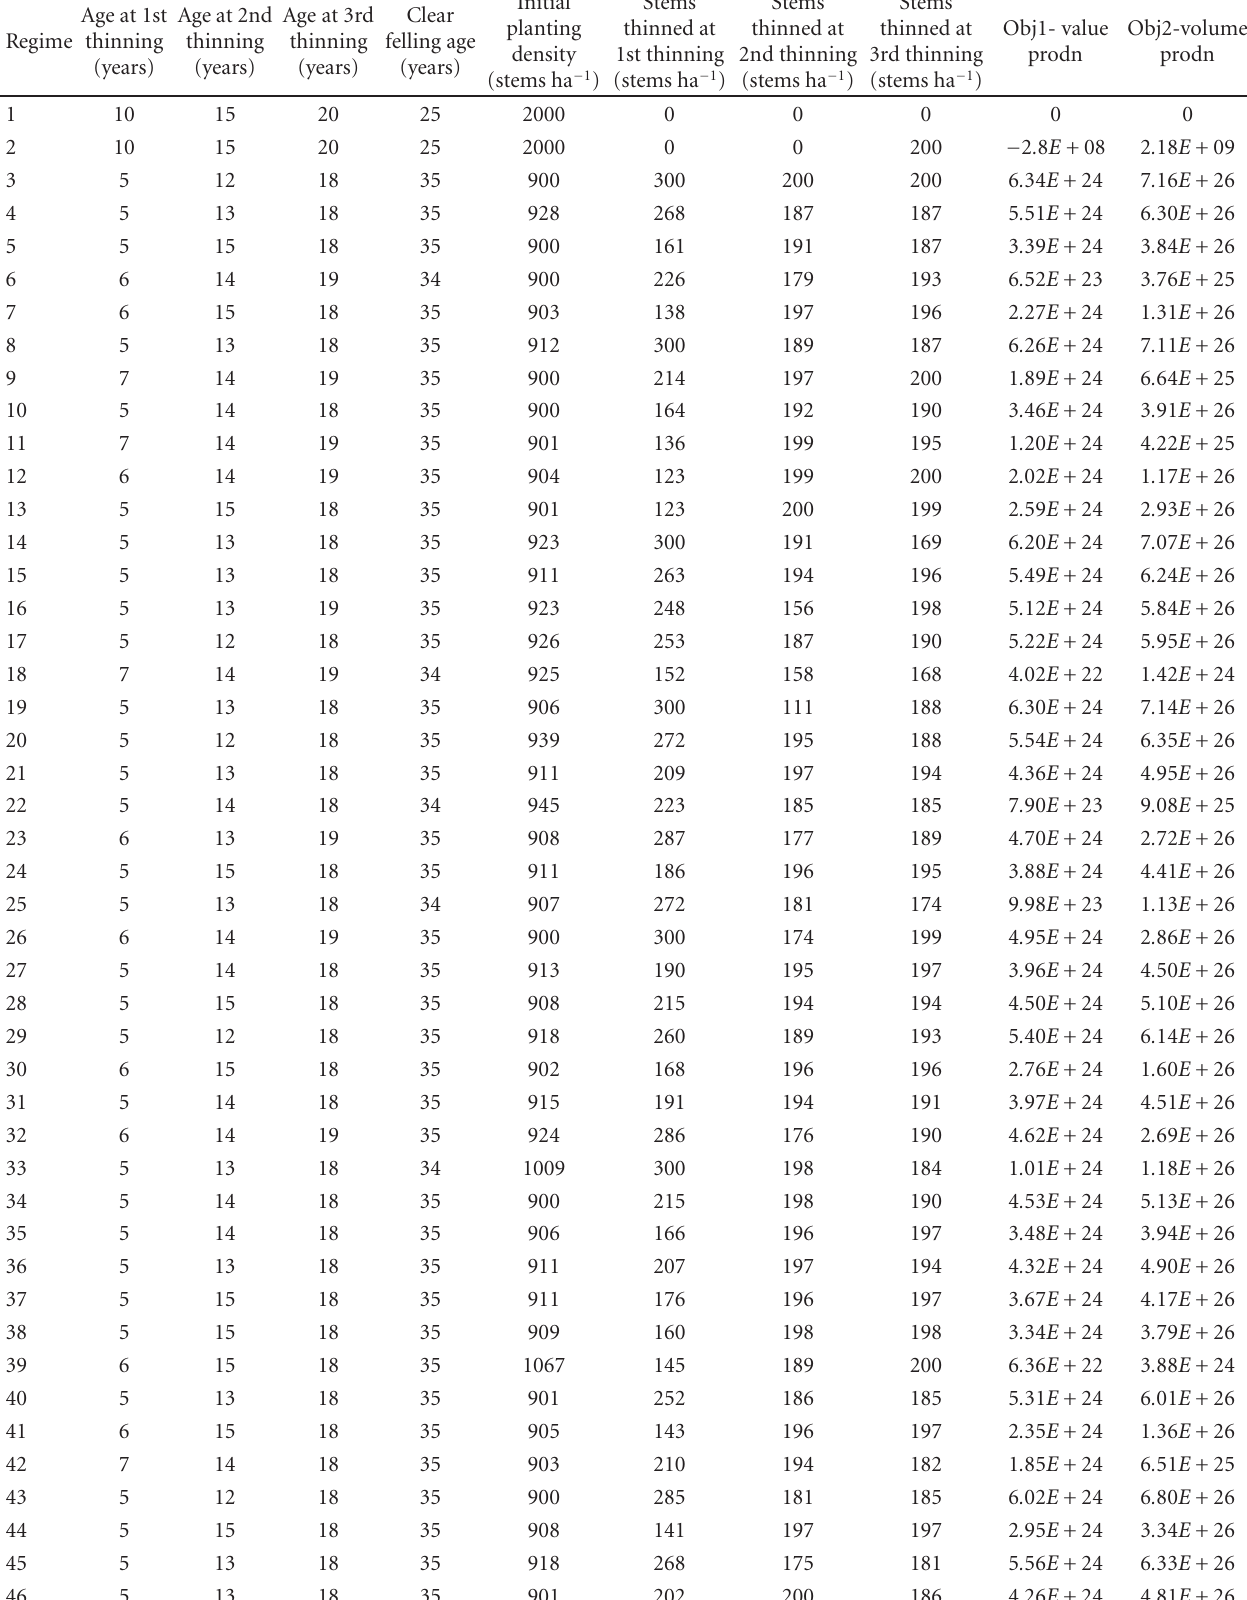
Table 7: A Pareto set estimated using NSGA